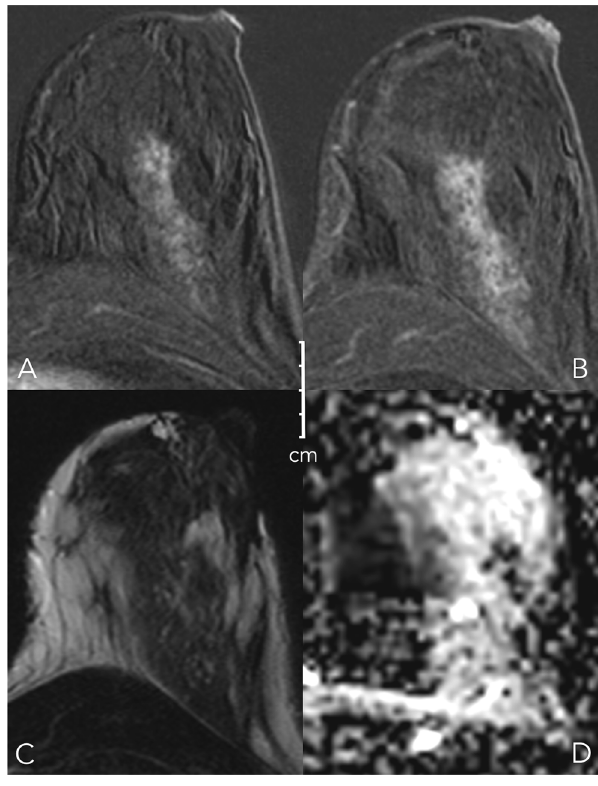
Fig. 9 Early (A) and delayed (B) contrast-enhanced subtractions, T2w (C), and ADC map (D). Mass lesion in the left breast of a 41-year-old female with newly developed bloody discharge. The lesion shows no spiculations, circumscribed margins (first subtraction), and a plateau- type enhancement curve, corresponding to a Kaiser score of 2, practically excluding malignancy (Fig. 6). Note the intraductal lesion location on T2w and the intermediate low ADC (1.1*10 -3 mm 2 /s). Findings are pathognomonic for a benign papilloma. The symptomatic lesion was resected and histopathology revealed a benign papilloma without atypia